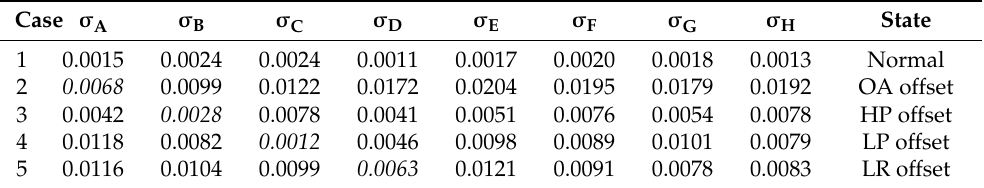
Table 9. The results of fault